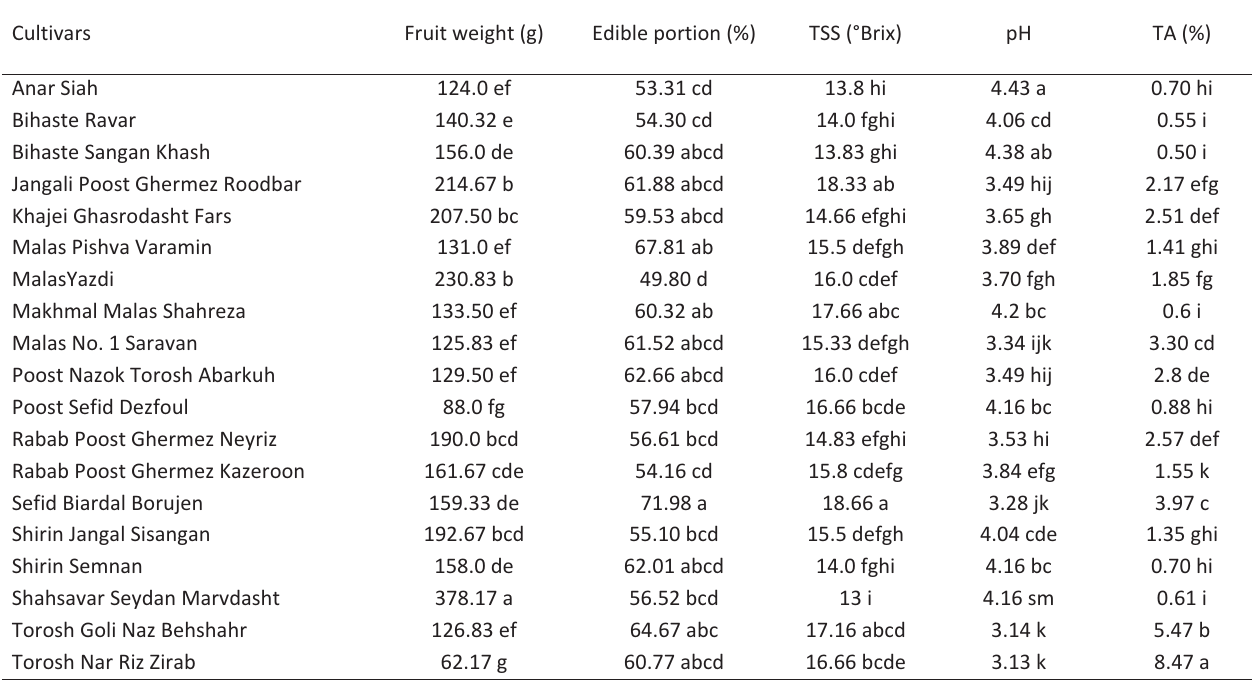
Similar letters in each column indicate non­significant differences among cultivars at